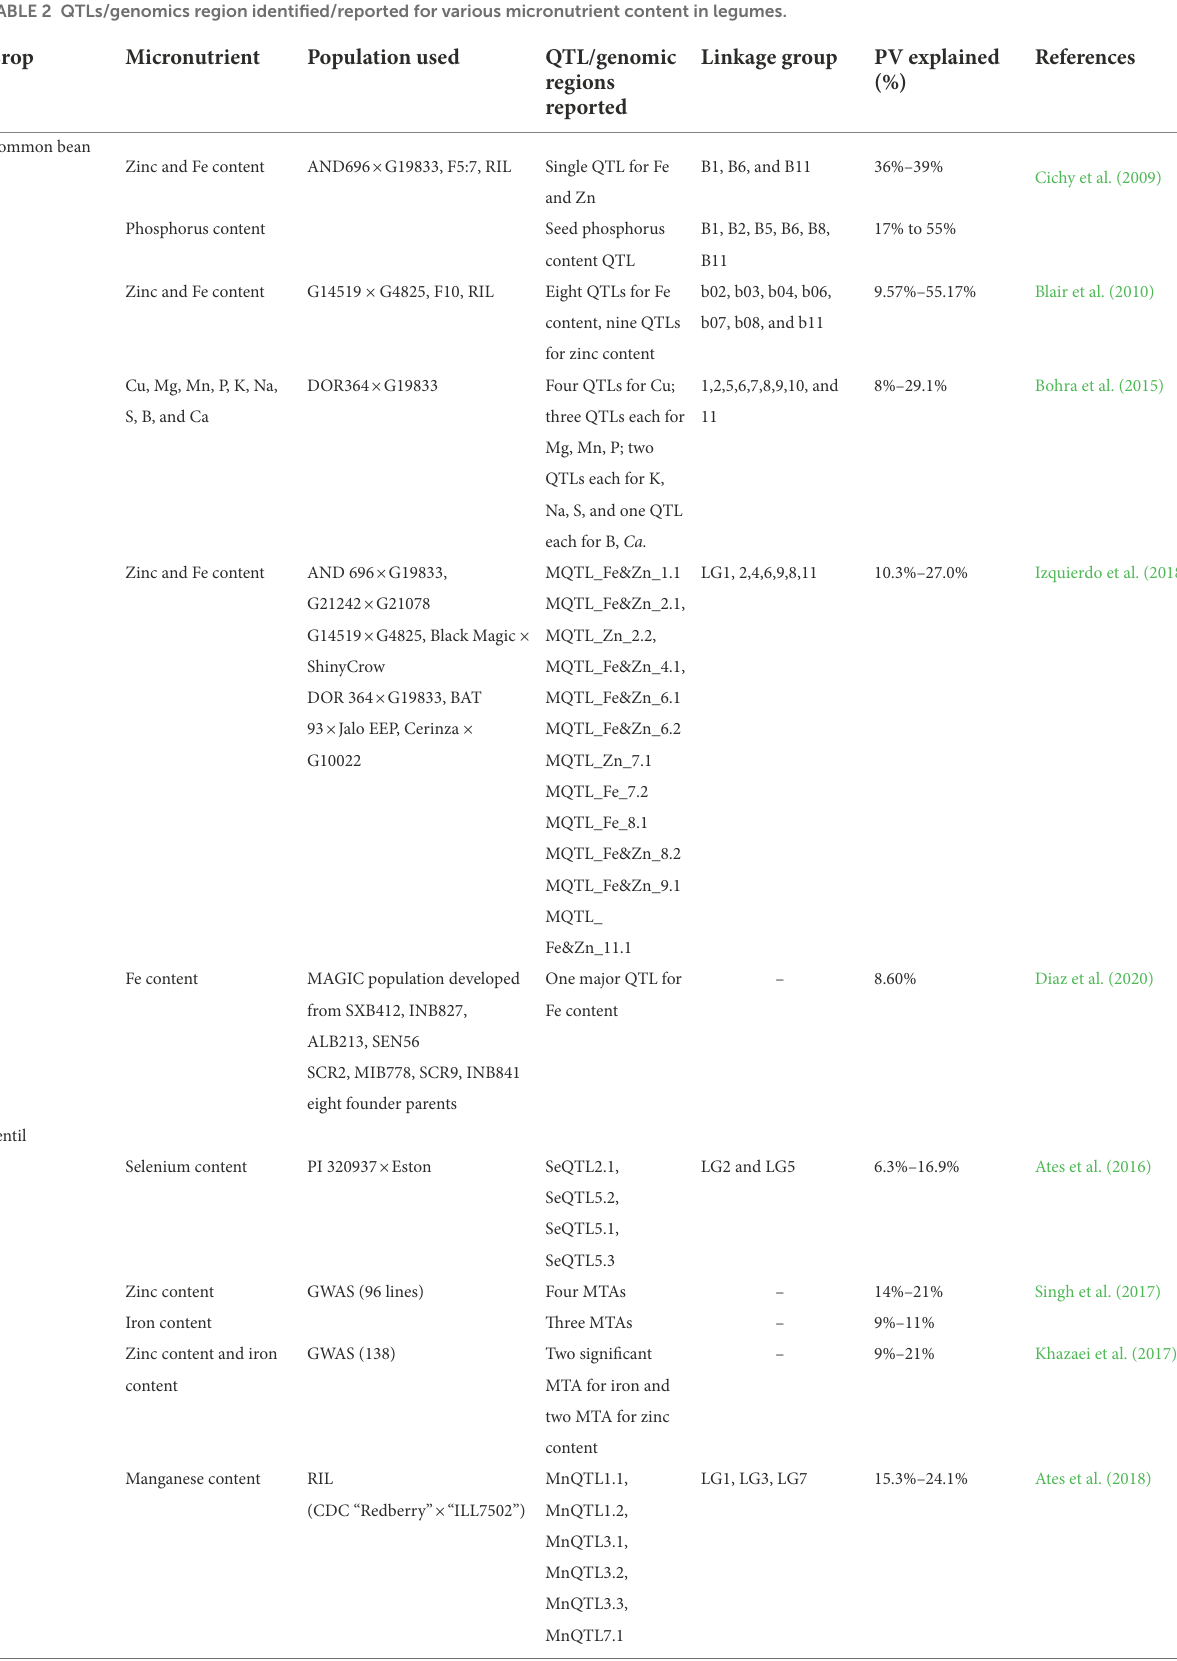
TABLE 2 QTLs/genomics region identified/reported for various micronutrient content in